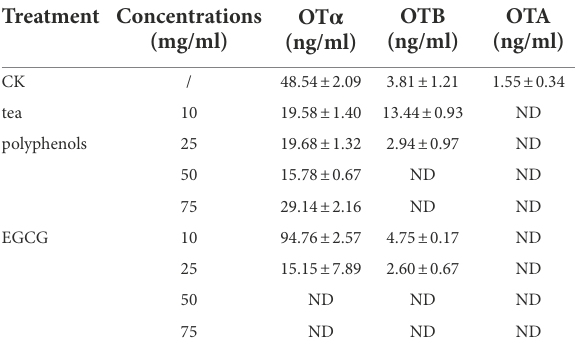
TABLE 3 Concentrations of OT α , OTA, and OTB after treatment with different concentrations of TPs and EGCG. Treatment